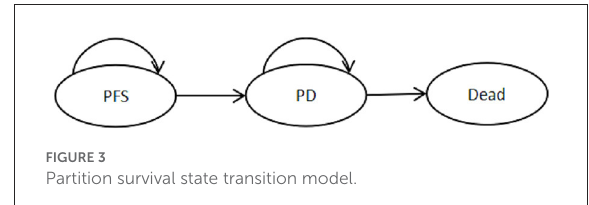
FIGURE3 Partition survival state transition model.